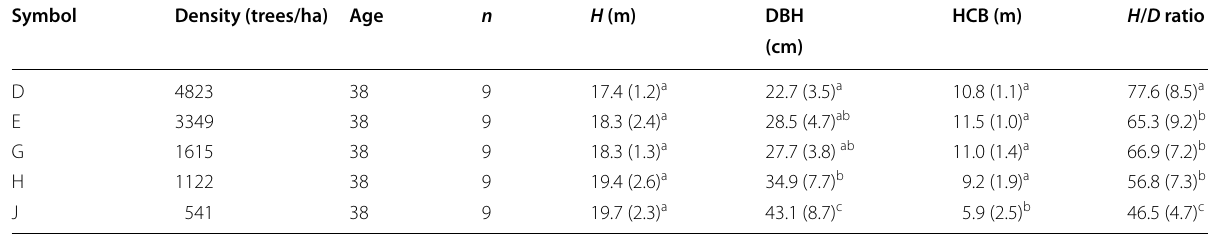
The values represent averages in three trees; values in parentheses indicate standard deviations. Different characters show significant differences among density- zoning symbols (Tukey HSD), p < 0.05) H / D ratio was calculated by the following formula. H/D ratio